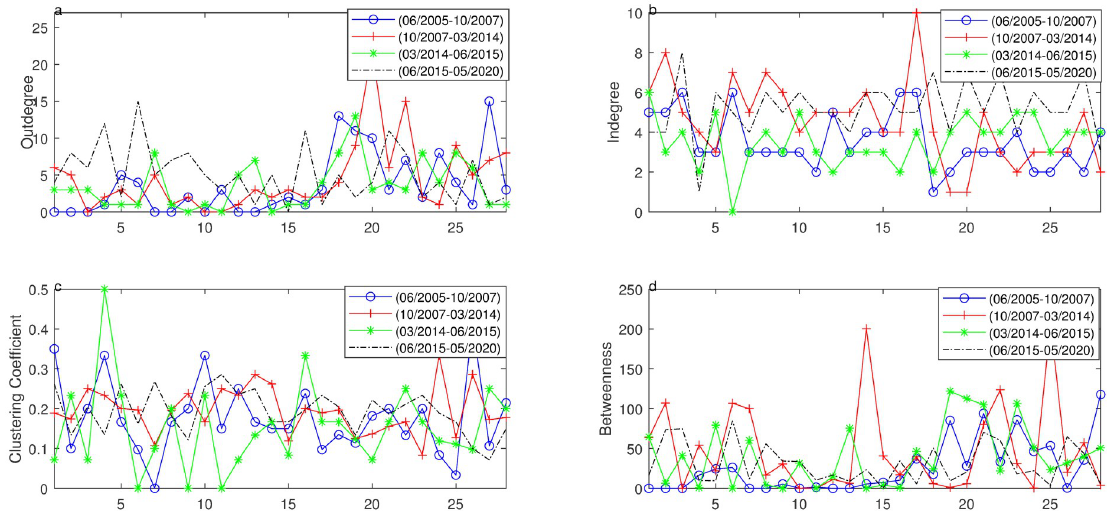
Fig 3. The topology of networks based on 28 industry sectors over four segments. The curve with circle represents the first segment, the curve with cross represents the second segment, the curve with asterisk represents the third segment and dotted curve represents fourth segment. a – d are respective distributions of outdegree, indegree, clustering coefficient and betweenness over four segments.